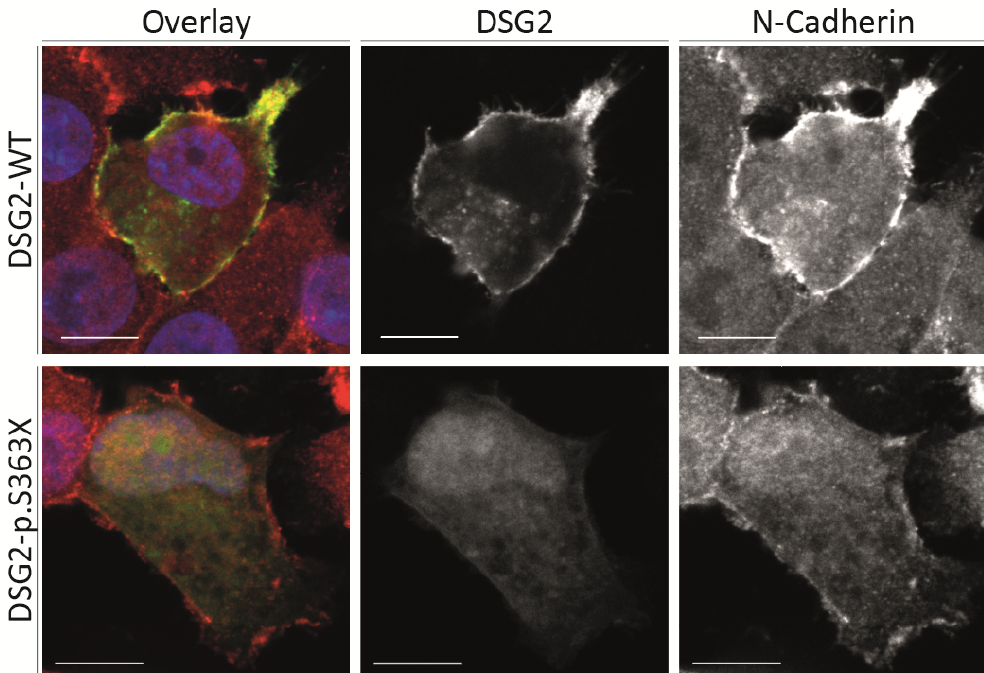
Figure 6. Cell transfection experiments reveal absence of truncated DSG2 at the plasma membrane. HT-1080 cells were transfected with pEYFP–N1–DSG2 (WT = wild-type) or the truncated pEYFP–N1–DSG2–p.S363X plasmids. The fluorescence signal of DSG2-EYFP is shown in yellow. N-Cadherin was costained using primary and Cy3-conjugated secondary antibodies and is shown in red. DAPI was used for staining of the nuclei and is shown in blue. Scale bars represent 10 µm. Of note, the truncated form of DSG2 is not localized at the plasma membrane.